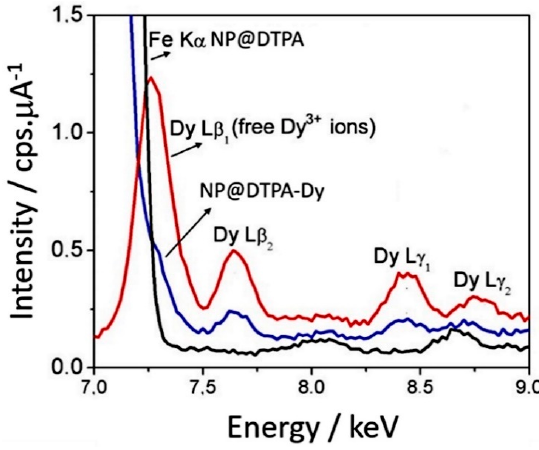
Figure 10. X-ray fluorescence spectra of the NP@DTPA, Dy 3+ free ions in equilibrium, and NP@DTPA- Dy, after the magnetic confinement (adapted with permission from [35]).